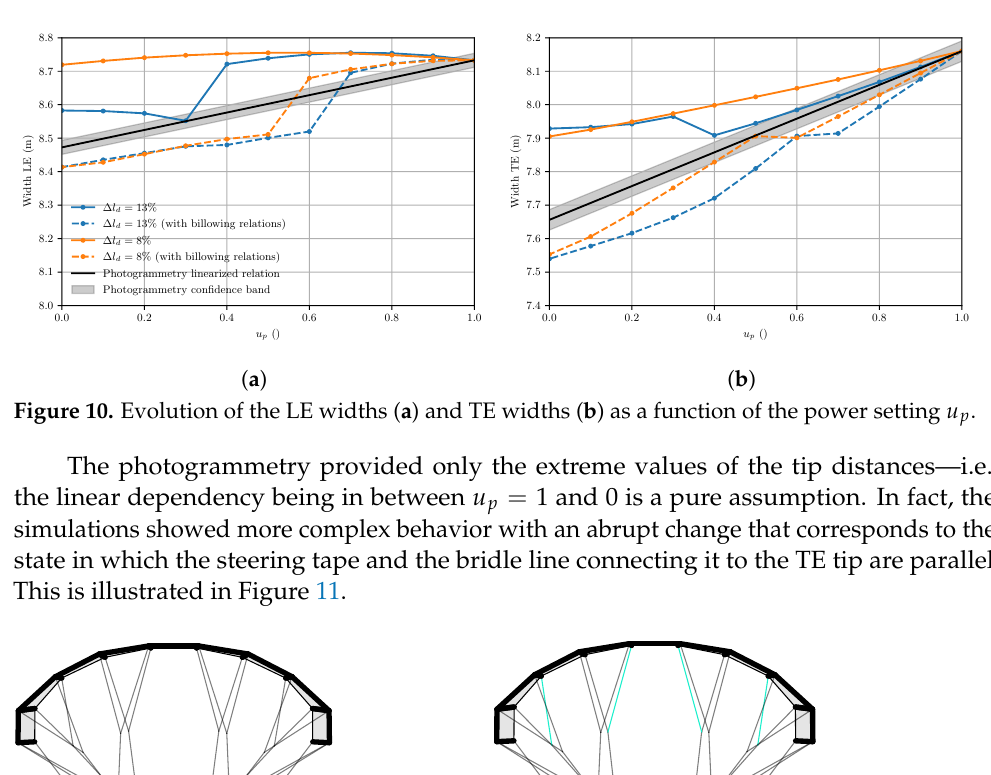
Figure 9. In black, the wing shape is in a fully powered state ( u p = 1), and in red, the wing shape is in a fully depowered state ( u p = 0), for ∆ l d = 8%, displayed in an orthographic view ( top left ), a top view ( top right ), a side view ( bottom left ), and a front view ( bottom right ) [26].